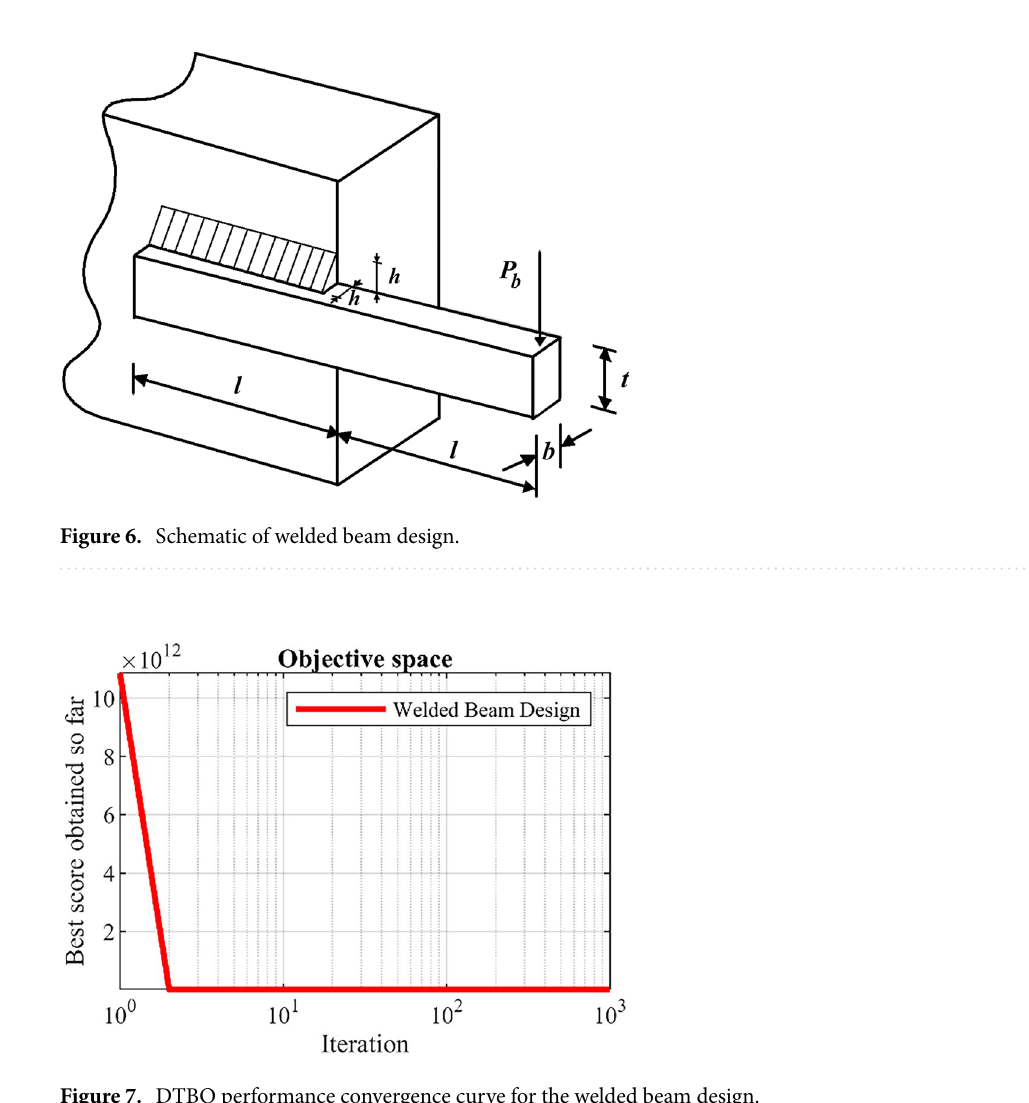
Figure 7. DTBO performance convergence curve for the welded beam